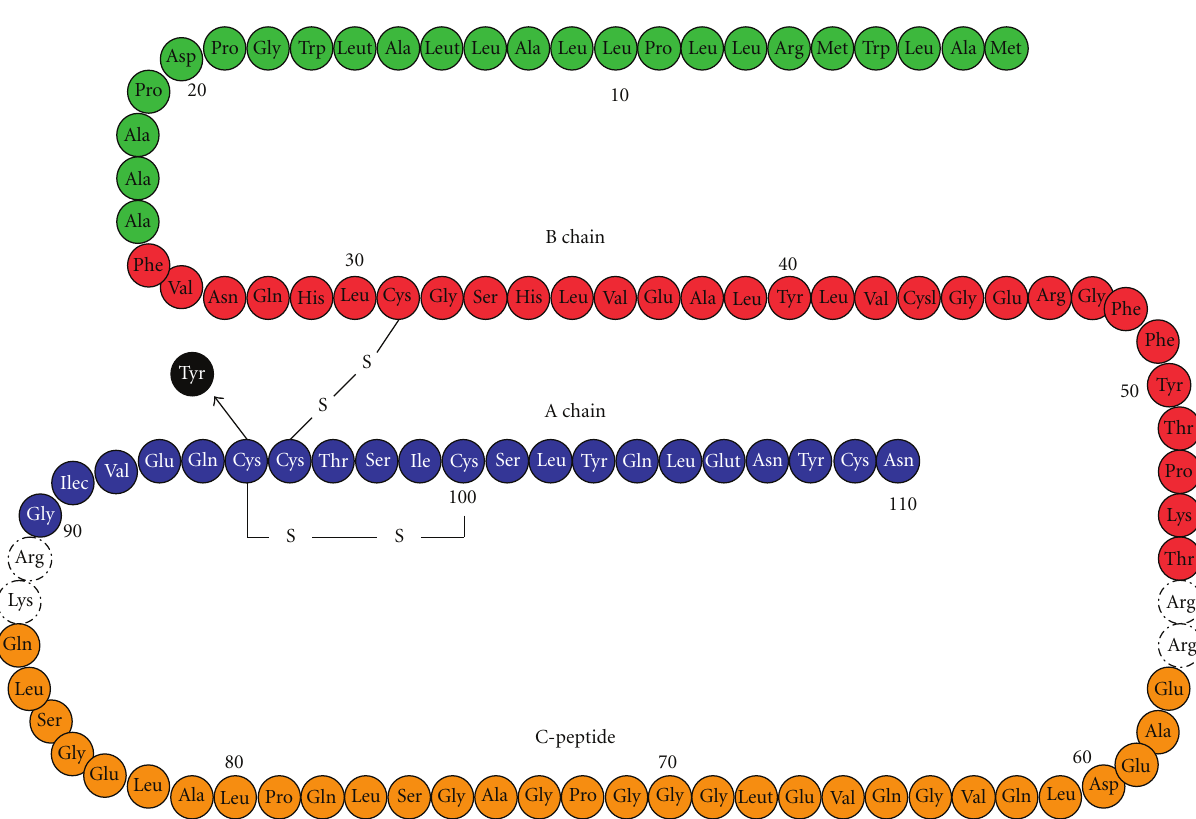
Figure 2: Diagram representing the human preproinsulin molecule marking the location of the C95Y mutation found in the three family